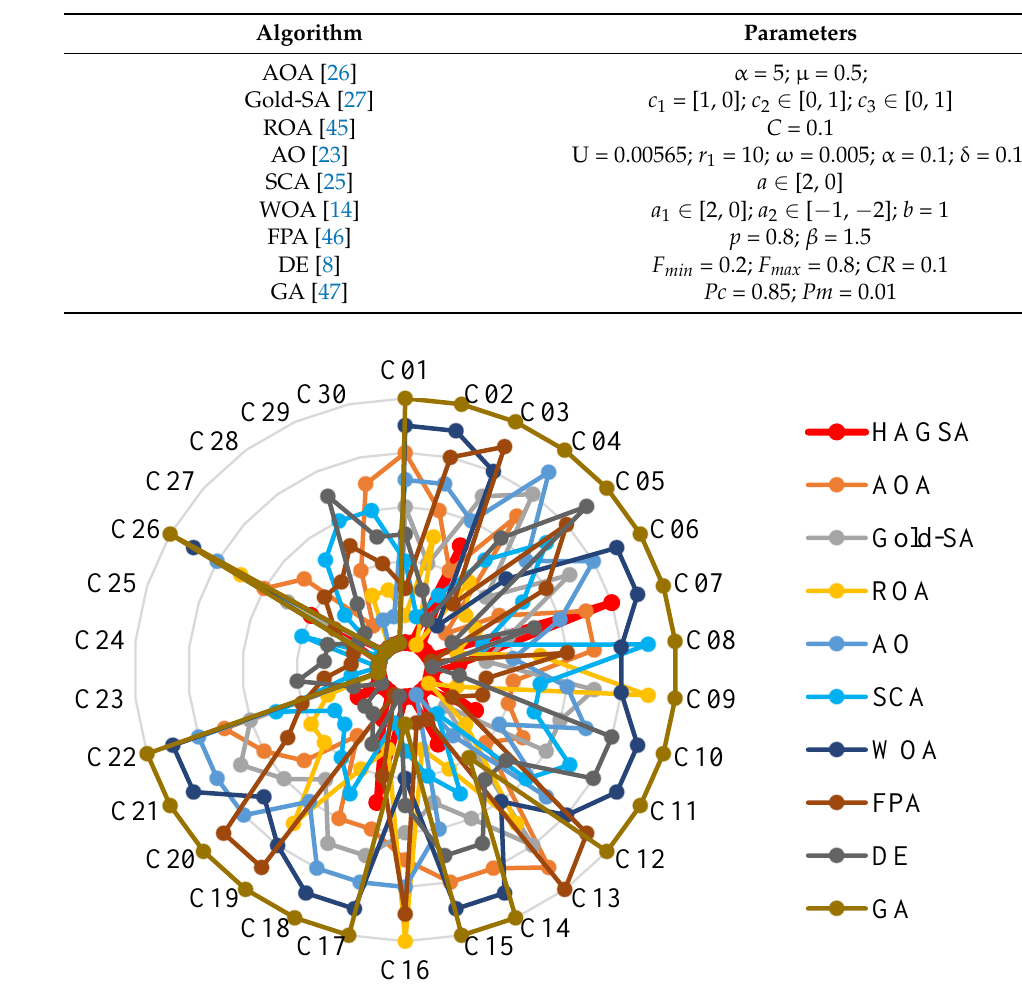
Figure 7. The radar graphs of algorithms on CEC 2014 benchmark functions.